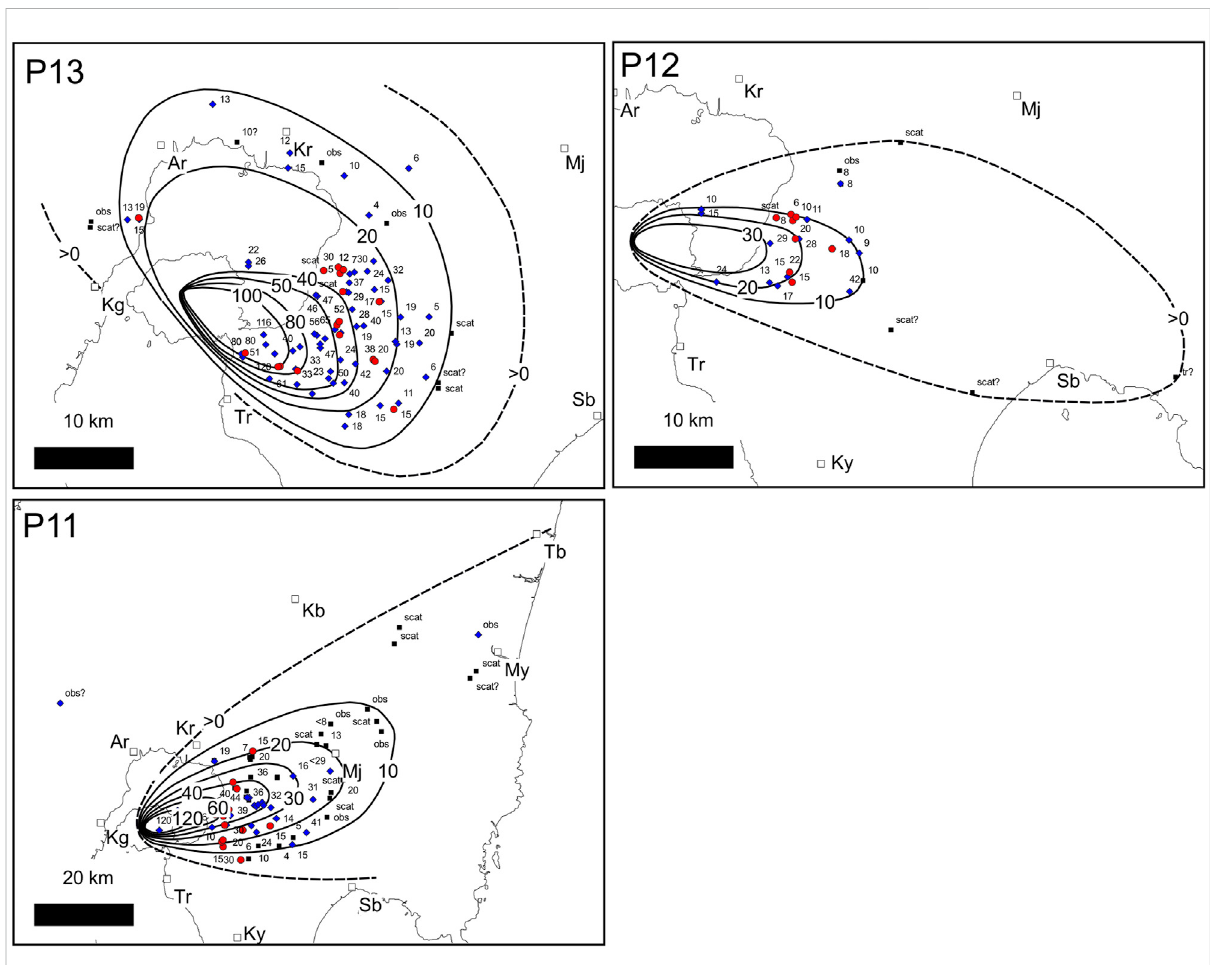
FIGURE 7 Distributions of the P13-P11 pumice fall deposits. Legend is the same in Figure 3A. Solid white squares indicate the location of major cities, and the abbreviations are the followings: Ar, Aira city; Kg, Kagoshima city; Kr, Kirishima city; Mj, Miyakonojo city; My, Miyazaki city; Sb, Shibushi city; Tr, Tarumizu city; Tb, Takanabe